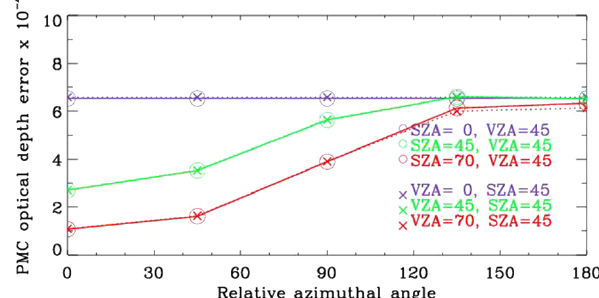
Figure 6. Same as Fig. 5c but for PMC optical depth retrieval errors (root sum square of random noise and smoothing